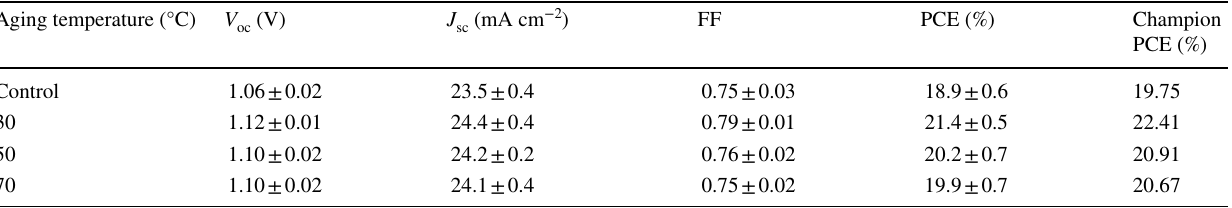
Thirty‑two devices were fabricated for each condition